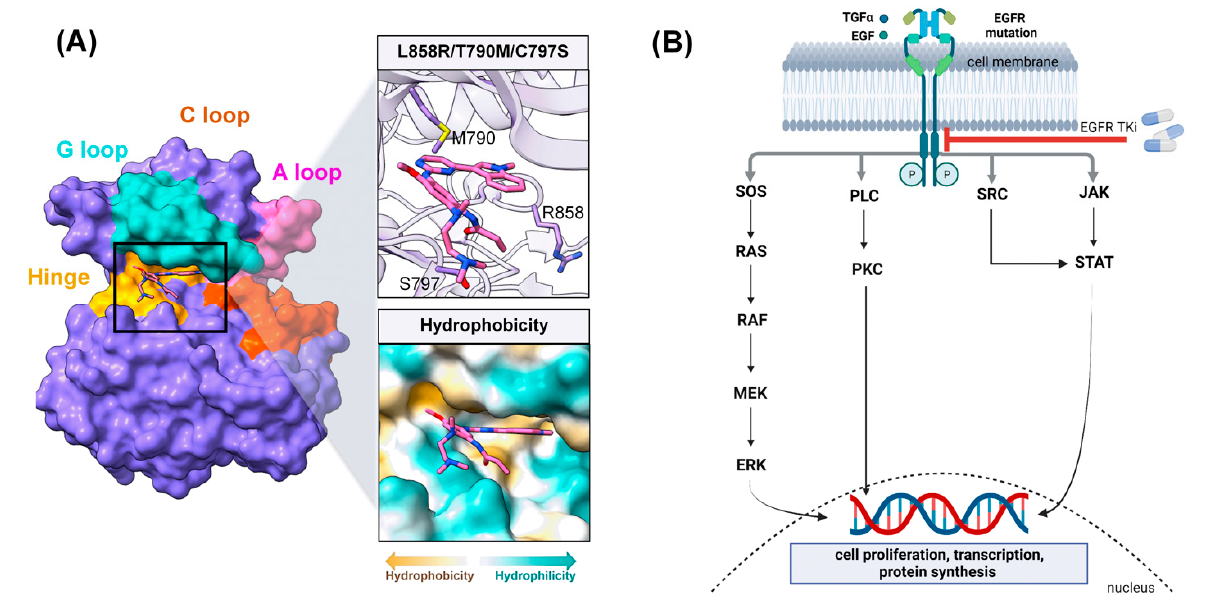
Figure 1. ( A ) 3D structure of EGFR (L858R/T790M/C797S) TK in complex with osimertinib (PDB ID: 6LUD) in which the mutated amino acids were shown in a close-up view as well as a hydrophobic character of its binding cleft. ( B ) EGFR signaling pathways including Sos/Ras/Raf/MEK/ERK, PLC/PKC, and JAK/STAT signaling cascade that control cell differentiation, proliferation, and survival responses [4,33]. (adapted from Ref. 4,33 and created with BioRender.com, accessed on 30 October 2022).